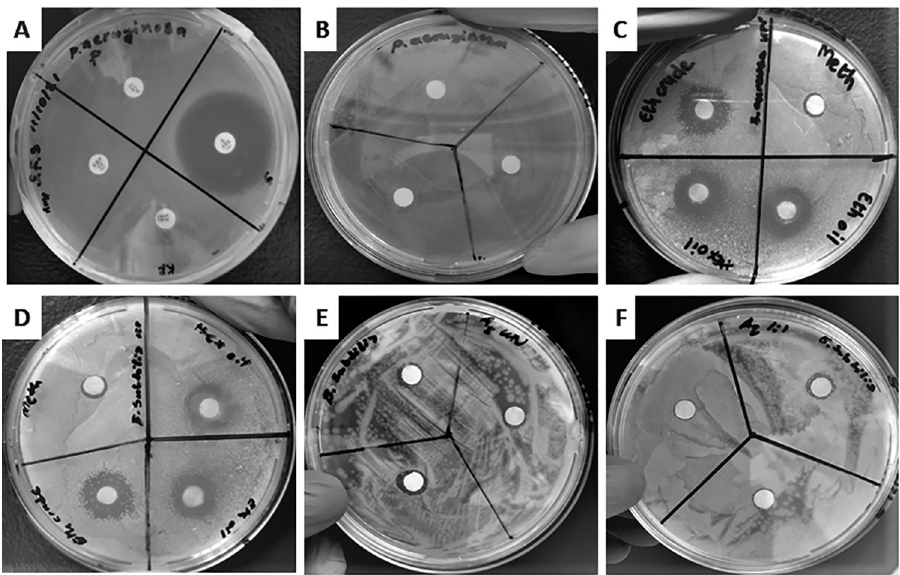
Fig 6. Inhibitory effects of different preparations/extracts of N . sativa seeds, positive treatment, and negative treatment against pathogenic bacterial strains. (A): Inhibitory activity of streptomycin (S) against P . aeruginosa . (B): Negative treatment using double distilled water no inhibitory activity was observed for all the tested pathogenic bacterial strains (i.e., P . aeruginosa ). (C): Inhibitory activity of undiluted extracts of N . sativa seeds (oil extracted using absolute ethanol, oil extracted using hexane and methanol extract) against S . aureus where absolute ethanol had the highest zone of inhibition followed by oil extracted using absolute ethanol and oil extracted using hexane while methanol extract was the least potent. (D): B . subtilis , all diluted extracts were active with reduced efficacy as opposed to that of the undiluted ones. (E): Inhibitory activity of the undiluted aqueous extract against B . subtilis . (F): Inhibitory activity of the diluted aqueous extract with reduced efficacy compared to the undiluted aqueous extract.